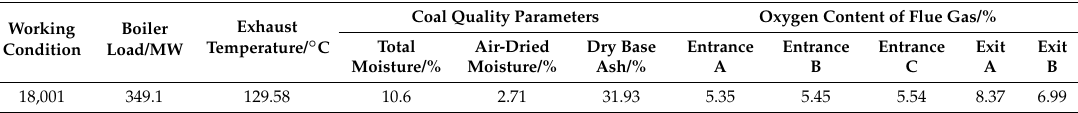
Table 5. The value of the non-adjustable